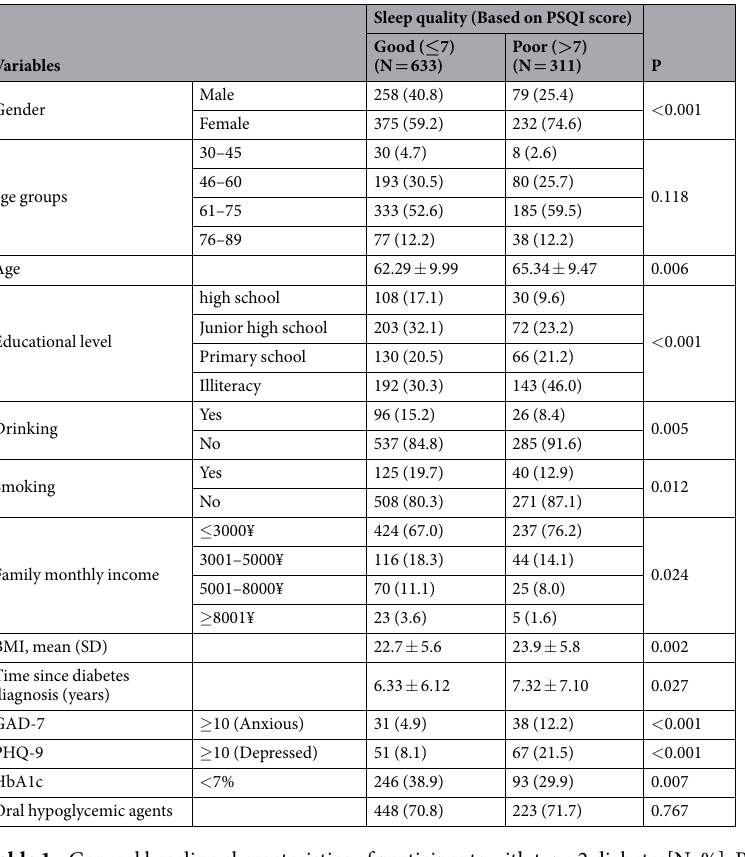
Table 1. General baseline characteristics of participants with type 2 diabetes[N, %]. P values were obtained using the Fisher exact test for categorical variables and the Mann-Whitney U test for continuous variables. GAD-7 = Generalized Anxiety Disorder 7 scored on 0–21 scale, a low score. favourable 10; PHQ-9 = Patient Health Questionnaire 9 scored on 0–27 scale, a low score. favourable 10;. HbA1c = glycated hemoglobin.